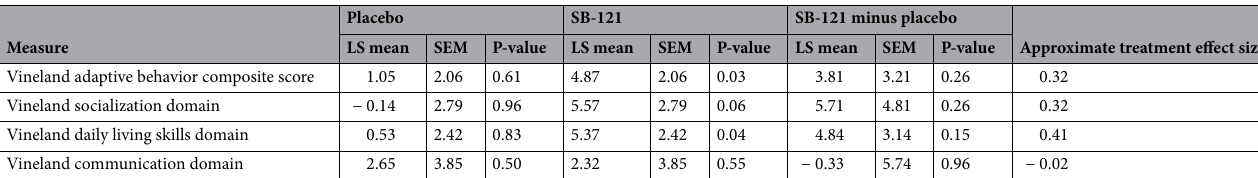
Table 4. Summary of Vineland-3 Scores (change from baseline). LS least squares, SEM standard error of the mean. For each measurement, the response was the difference between post-dose and pre-dose value. The adjusted, or LS mean for each treatment (SB-121 or placebo) and its standard error were derived from the model. The LS means differences between SB-121 and placebo (SB-121 LS mean minus Placebo LS mean) and their standard errors were also assessed. Statistical significance was set at a two-sided alpha = 0.05 and no adjustment was made for multiple comparisons. An approximate treatment effect was derived from the difference between the LS means for the SB-121 and placebo change from baseline and its standard error. All statistical analyses were conducted using SAS® statistical software version 9.4 for Windows (SAS Institute Inc., Cary,